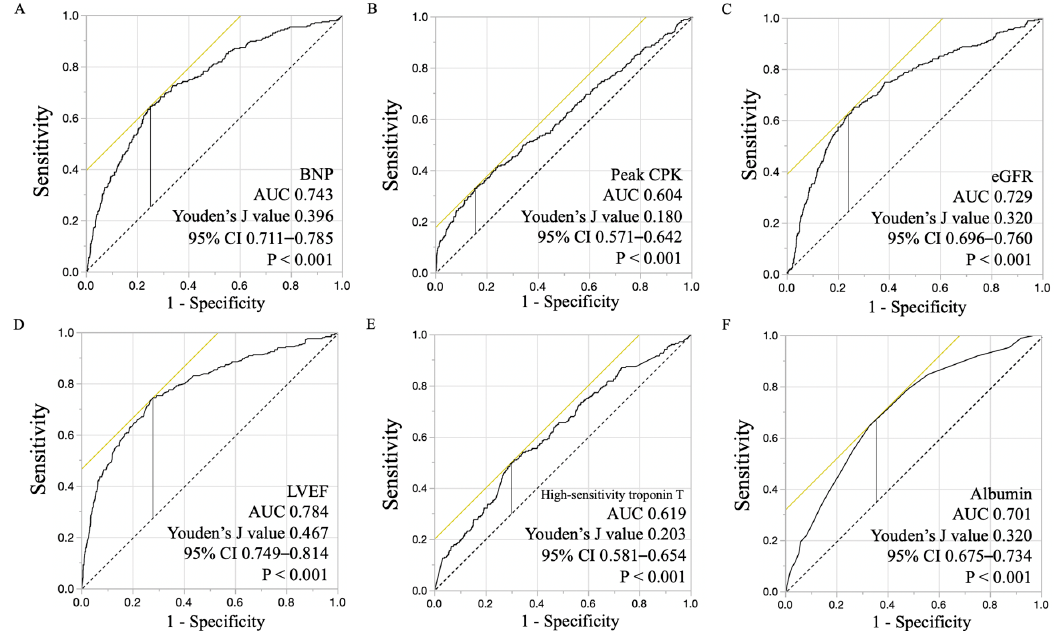
Figure 3. Receiver operating characteristic curve with area under the curve (AUC) of primary composite outcome: brain natriuretic peptide (BNP) ( A ), peak creatine phosphokinase (CPK) ( B ), estimated glomerular filtration rate (eGFR) ( C ), left ventricular ejection fraction (LVEF) ( D ), high-sensitivity troponin T ( E ) and albumin ( F ).